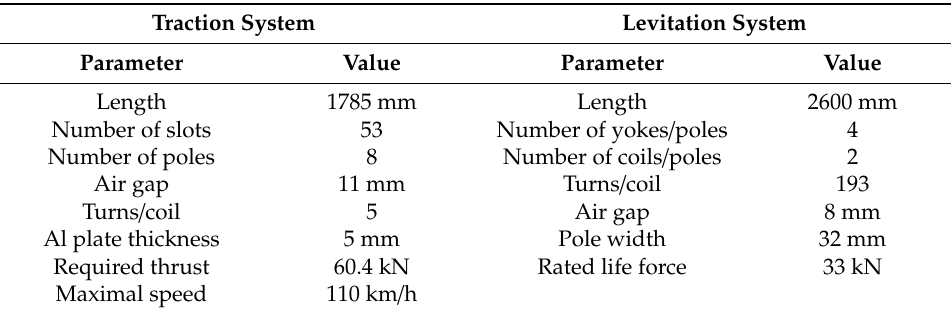
Table 3. Experimental vehicle specifications.